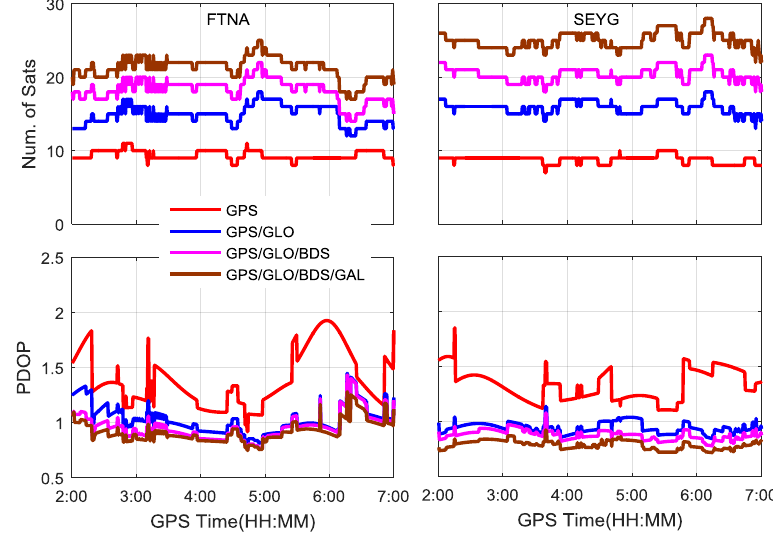
Figure 5. Number of satellites and PDOP for different PPP processing scenarios using datasets at FTNA and SEYG stations on 5 September 2016.